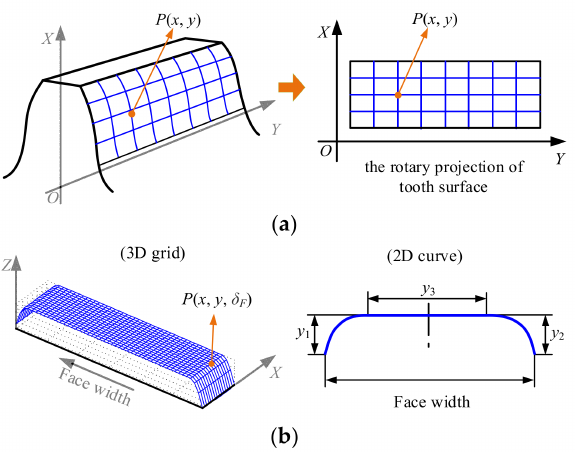
Figure 6. Designation of tooth modification. ( a ) Gridding surface of the unmodified tooth; ( b ) Grid- ding surface of the modified value.